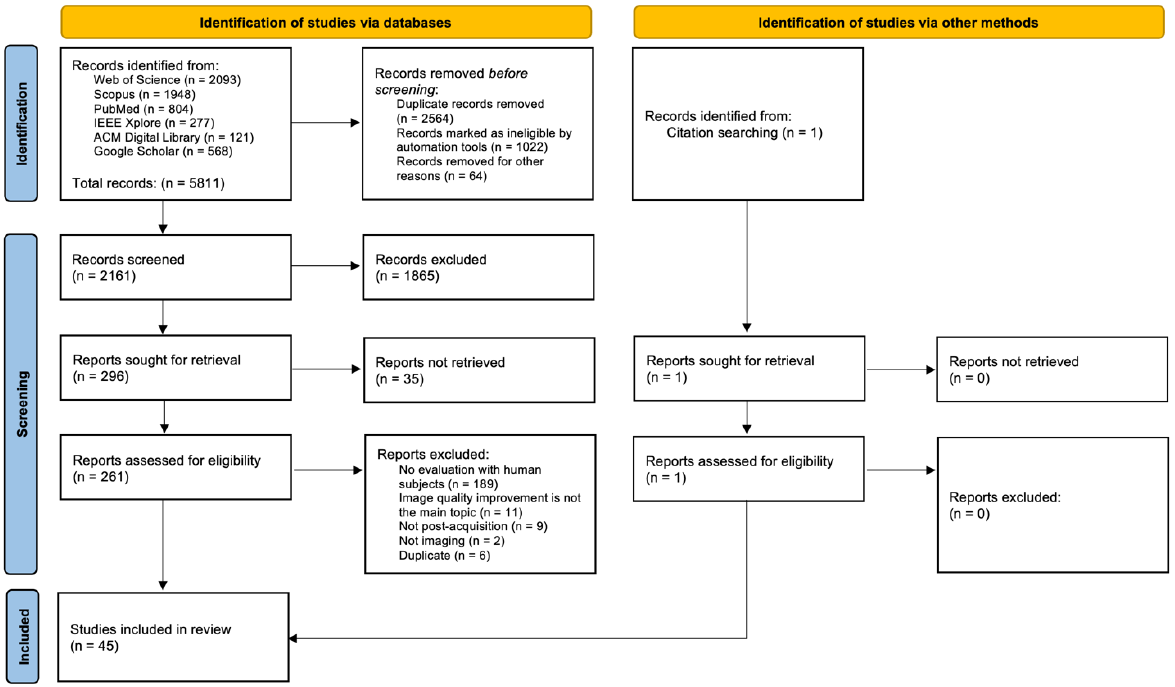
Figure 5. An overview of the literature search and screening procedure. The flow diagram was created according to PRISMA 2020 guidelines for systematic reviews [56].